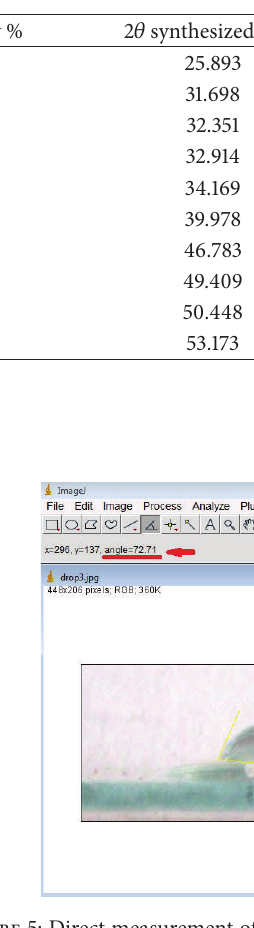
Figure 5: Direct measurement of contact angle using Imagej 1.64r